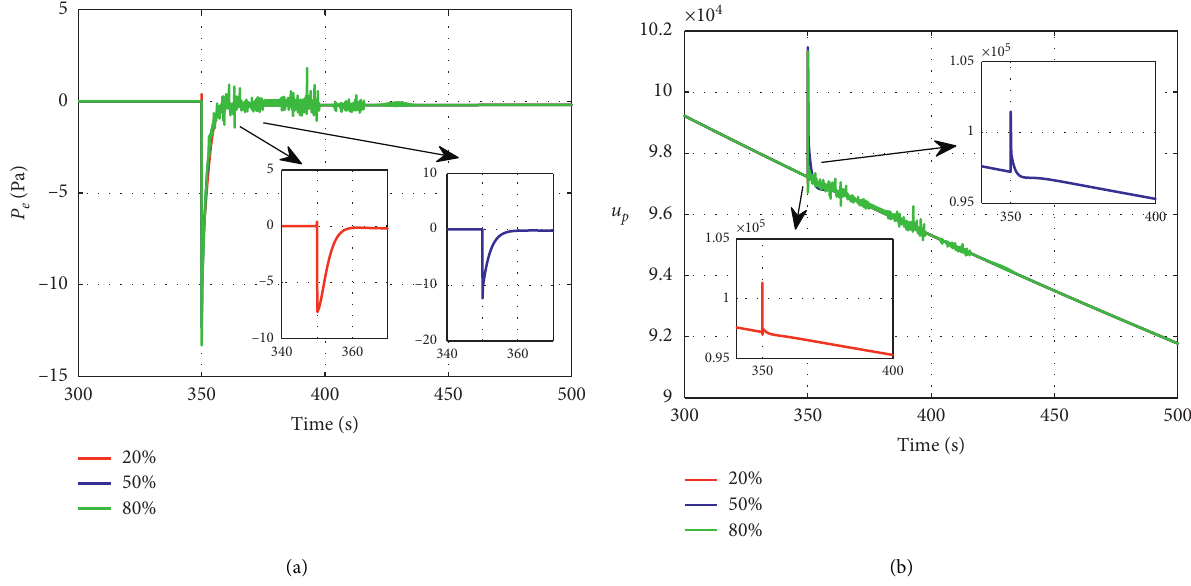
Figure 10: Pressure error and control input of actuator partial failure after reconfiguration.